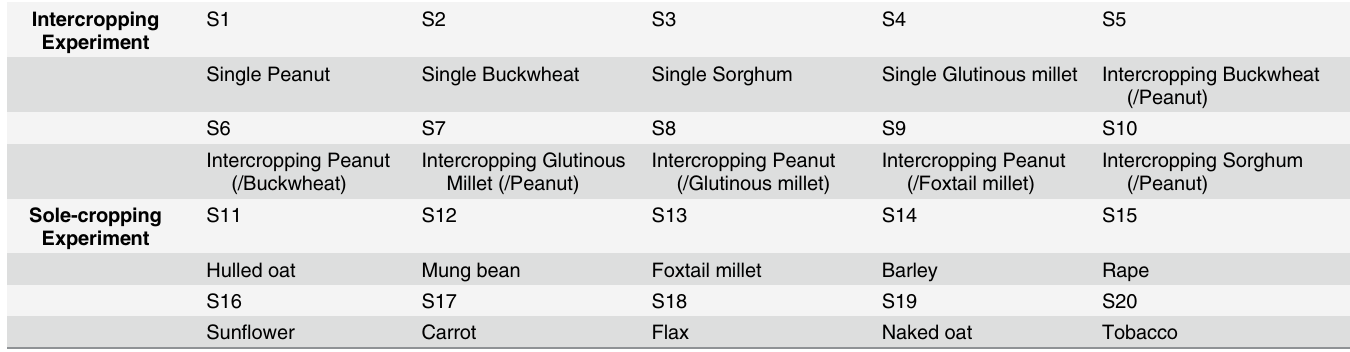
Table 2. Code number for 20 collected soil